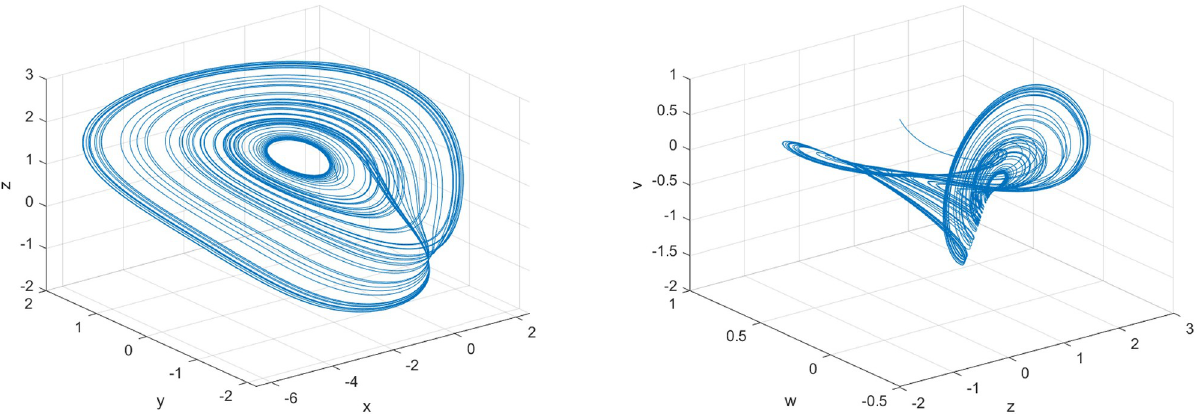
Fig 2. Phase diagram of the new five-dimensional three-leaf chaotic system. (a) x - y - z ,(b) z - w - v .